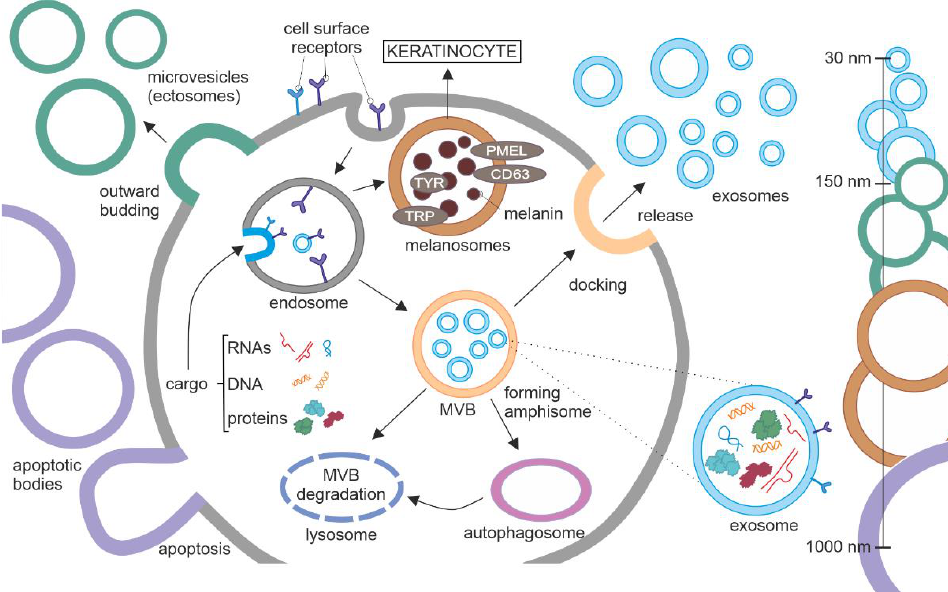
Figure 1. Biogenesis of extracellular vesicles (EVs). EVs can be categorized based on their size as follows: (1) apoptotic bodies, the largest (1 –4 μm in diameter); (2) ectosomes/microvesicles belong